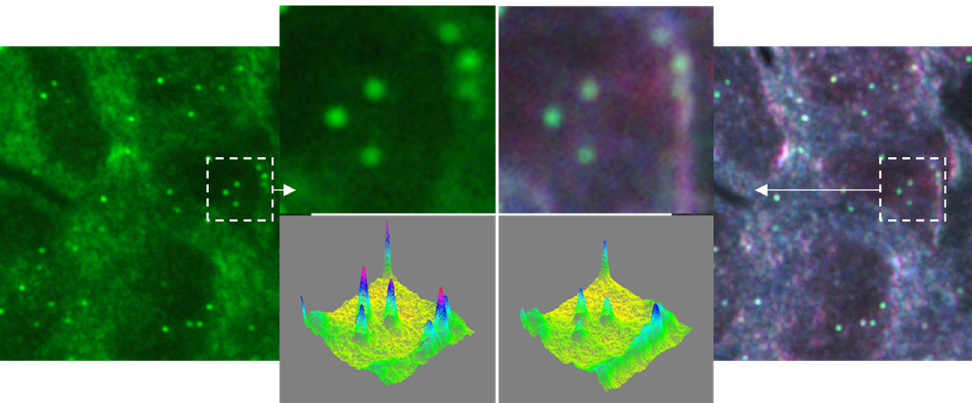
Figure 4. Monochromatic (green LED) and RGB SI dark-field imaging H&E-stained cytology sample labeled with alloy spherical NPs (74 nm in diameter). Images were taken with Nikon 60× objective (0.7 NA). Insets compare the intensity profile of the NPs.